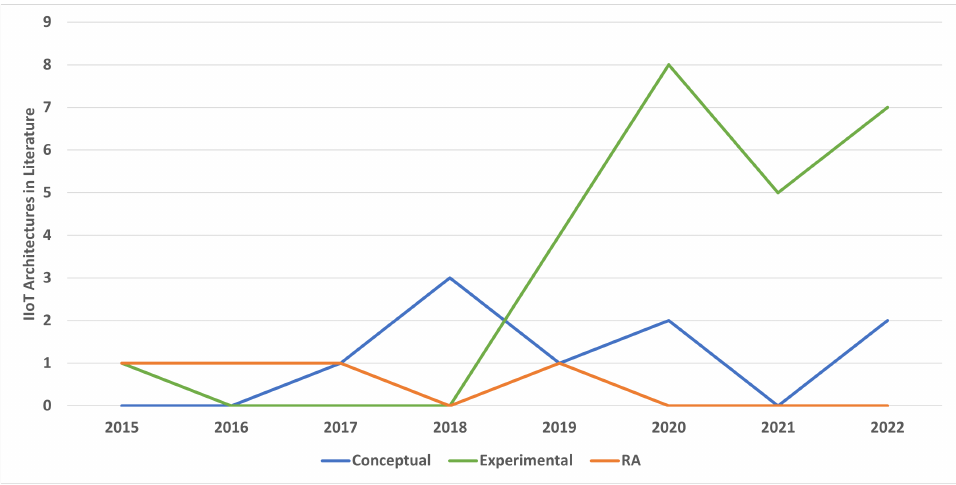
Figure 7. Conceptual and experimental architectures in the